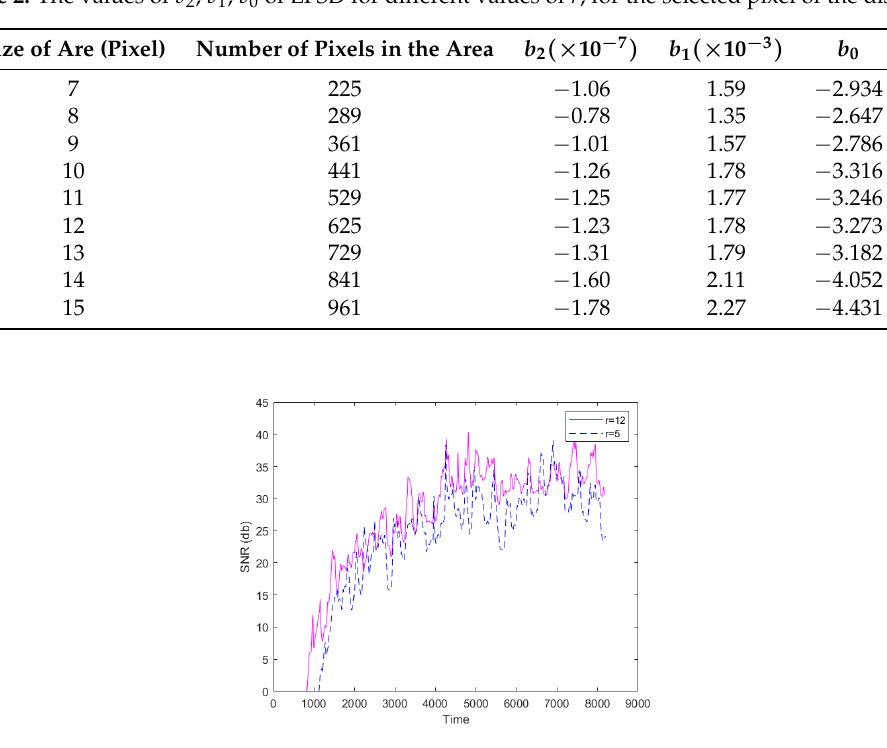
Figure 9. The instantaneous signal-to-noise ratio (SNR) for the population curve in Figure 8, calculated for ROI size r = 5 and r = 12.